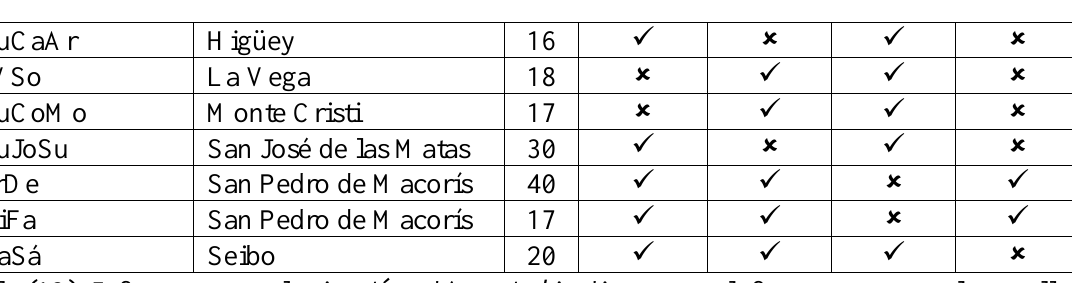
Table (13): Informants employing tú and/or usted in direct non-cleft non-argumental as well as argumental wh